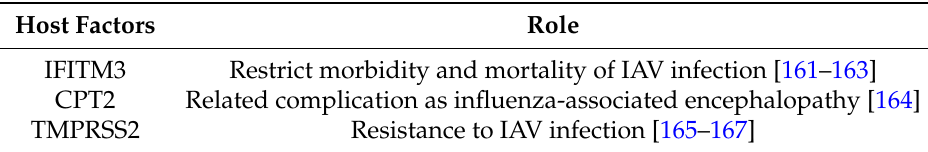
Table 3. Host Genetic factors. Host factors identified having a crucial role to determine severity of IAV infection in different